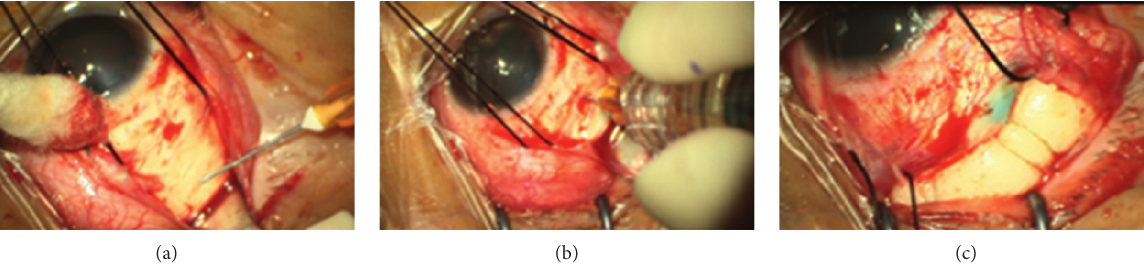
Figure 2: DVCE procedure. (a) Drainage. Puncture and drainage of the scleral wall corresponding to the highest point of the retinal bulge. (b) Injection of the viscoelastic agent. After supplying the subretinal fluid, a puncture was made 4 mm behind the limbus of the cornea and into the vitreous cavity to inject the viscoelastic agent for increasing intraocular pressure. (c) External pressure (explant). A suitable silicon sponge block or silicone tape was placed at the position of the